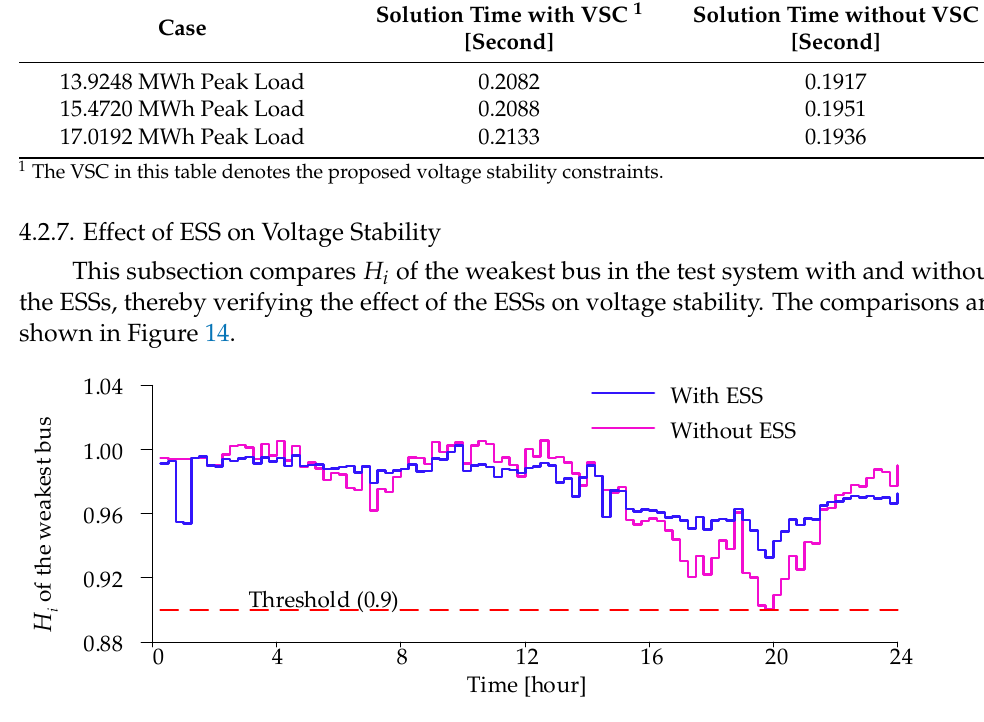
H values under the cases with and without ESSs. Figure 14. Comparison of H i values under the cases with and without i